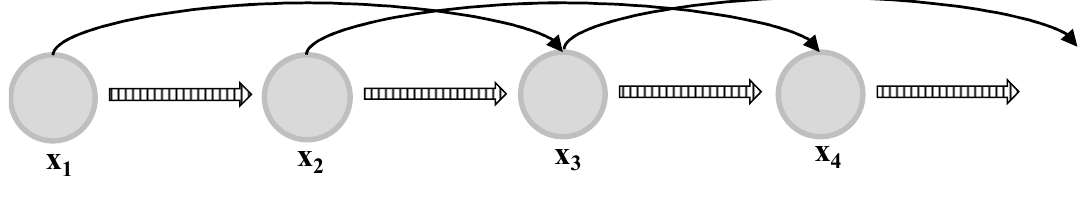
Figure 2. Second-order Markov chain.